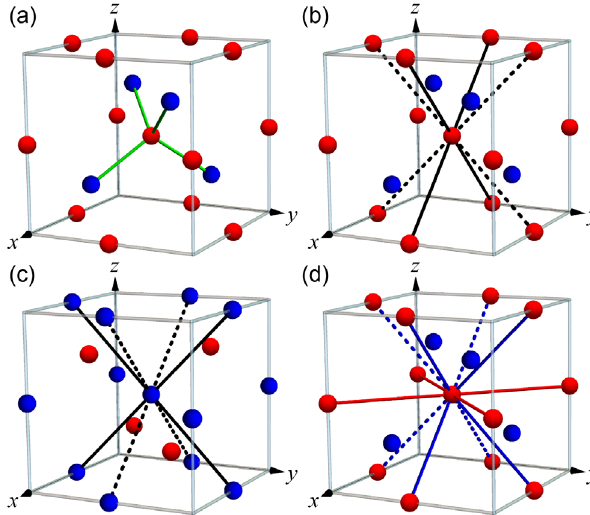
FIG. 8. Class AIII topological superconductor model on the diamond lattice [34]. Sublattice A ( B ) sites are indicated by red (blue) spheres, and are subject to the on-site potential μ [Eq. (23)]. (a) Nearest-neighbor hopping with amplitude t 0 [Eq. (21)]. (b) Next-nearest-neighbor hopping on the A sublattice [Eqs. (22) and (24)]. Solid line (dashed line) hopping amplitudes are equal to t= 2 ( − t= 2 ). (c) Next-nearest-neighbor hopping on the B sublattice [Eqs. (22) and (24)]. Solid line (dashed line) hopping amplitudes are equal to t= 2 ( − t= 2 ). (d) BCS pairing within each of the sublattices [Eqs. (25) and (26)]. The red lines indicate d - wave spin-singlet pairing in the xy plane; i.e., red bonds create singlet Cooper pairs with amplitude Δ = 2 . The blue lines indicate p -wave z -axial spin-triplet pairing in the xz and yz planes. Solid (dashed) bonds create total spin J z ¼ 0 pairs with amplitude Δ = 2 ( − Δ = 2 ).